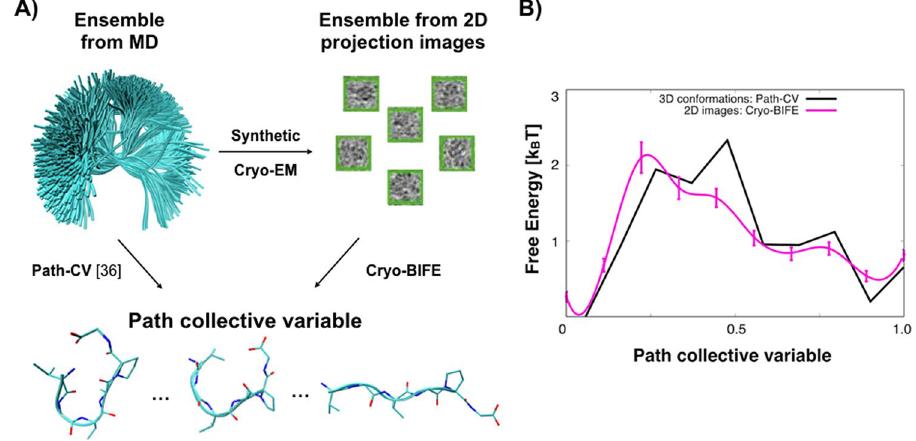
Figure 5. Free-energy profiles from 2D images (cryo-BIFE) or 3D conformations of the VGVAPG hexapeptide. ( A ) The conformational ensemble of the VGVAPG hexapeptide from MD simulations is used to generate synthetic images. The nodes belonging to the path (bottom) are selected with equally spaced end-to-end distances between successive nodes (see the Methods). The path-CV 36 method compares 3D conformations to the path nodes, whereas cryo-BIFE compares 2D particle images to the same nodes. ( B ) Free-energy profile calculated over the 3D ensemble using the path-CV with RMSD metric [Eq. (8) in Ref. 36 ] with (cid:31) = 50 Å –2 (black), and the expected free energy G ( s ) extracted using cryo-BIFE with synthetic cryo-EM particles (pink line). The R-hat test for the MCMC yielded values < 1.01 for all cases. The bars show the credible interval at 5% and 95% of the empirical quantile at each node. See the Methods for details about the path and set of images for each